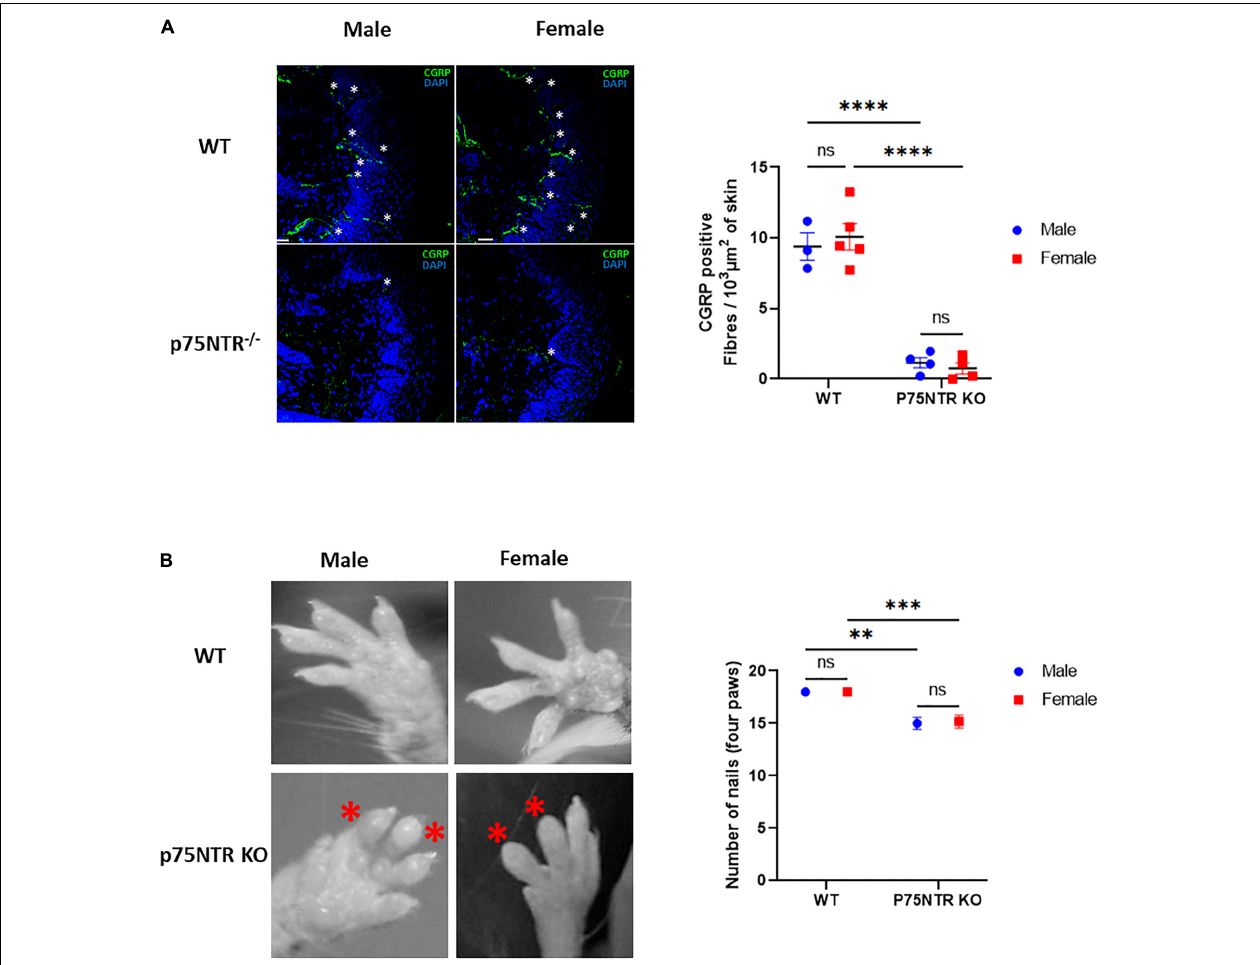
FIGURE 2 | Female and male p75NTR KO show similar defects in skin innervation and toes morphology. (A) The number of CGRP positive fibers (indicated with white*) crossing the epidermis was quantified using immunohistochemistry and confocal imaging. Three sections, from 3 WT males, 5 WT females, 4 p75NTR KO males, and 4 p75NTR females were quantified. Each dot represents the average number of fibers crossing the epidermis (expressed in µ m 2 ). Horizontal bars represent the mean for each genotype. ns, non-significant. **** p < 0.0001 two-way ANOVA followed by Tukey Multiple comparison test. (B) The four paws of WT and p75NTR KO males and females were screened for toe morphology. Male and female P75NTR KO mice show a similar swelling pattern with several missing nails. Total number of nails were quantified and compared with a two-way ANOVA followed by Tukey Multiple comparison test, ∗ ** p < 0.001, ∗ * p < 0.01 ( n = 7 WT males, 4 WT females, 3 p75NTR KO males, and 6 p75NTR KO